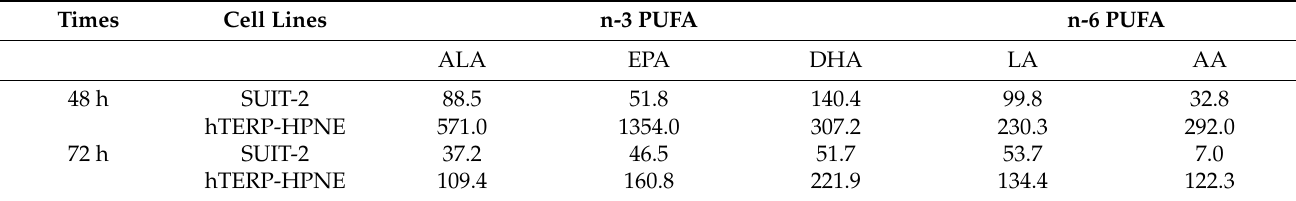
Table 1. Values of the 50% inhibitory concentration (IC 50 ) of omega-3 (n-3) and omega-6 (n-6) PUFA treatments in the SUIT-2 and hTERT-HPNE cell